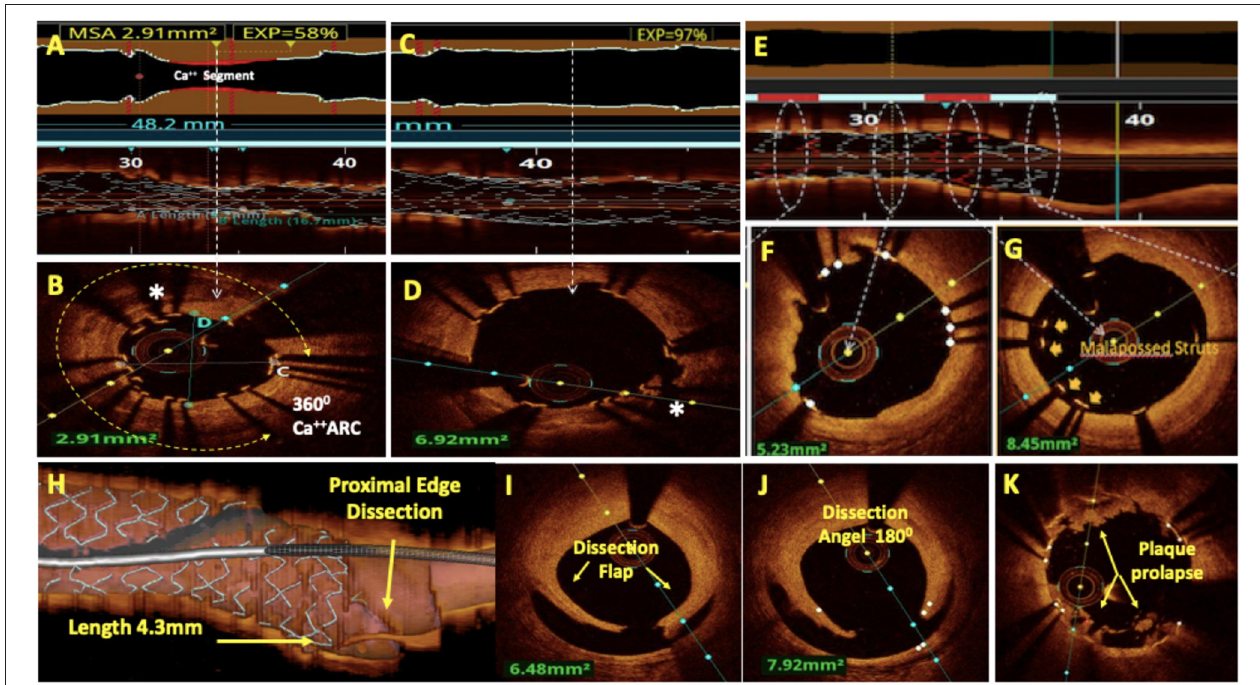
FIGURE 3 | Post-PCI assessment by OCT. (A) Lumenogram and L mode showed under-expanded stent (UES) with minimum stent area (MSA) of 2.91 mm 2 and 58% stent expansion. (B) Cross-sectional image at MSA revealed 360 ◦ arc of calcium as a cause of UES. (C) Lumenogram and L mode showed 97% stent expansion after the treatment of UES with ultra-high-pressure balloon dilatation. (D) A cross-sectional image shows the fracture of the calcium arc resulting in the resolution of the UES. (E) A rendered stent view shows well-apposed stent struts (white) and malapposed stent struts (red) corresponding to the white and red bars in the apposition indicator. Apposition (F) and mal-apposition (G) of the stent struts can also be well-appreciated on respective cross-sectional images. (H–J) : Major proximal stent edge dissection is seen with the dissection flap extending to media, dissection angle of 180 ◦ and 4.3mm dissection length on three-dimensional (3D) reconstruction. OCT with its better axial resolution enables clearer and more frequent visualization of in-stent tissue prolapse (K)